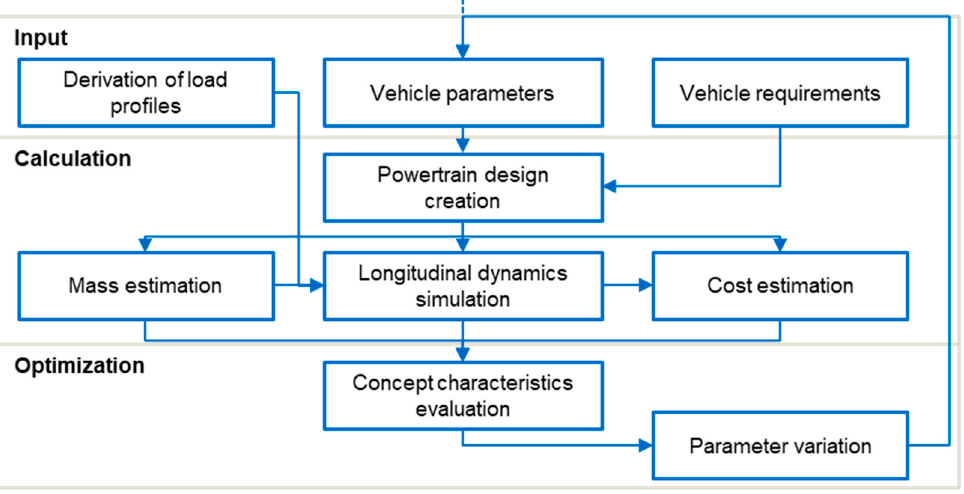
Figure 1. Powertrain concept optimization methodology.